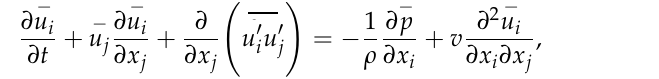
Figure 4. Longitudinal position.